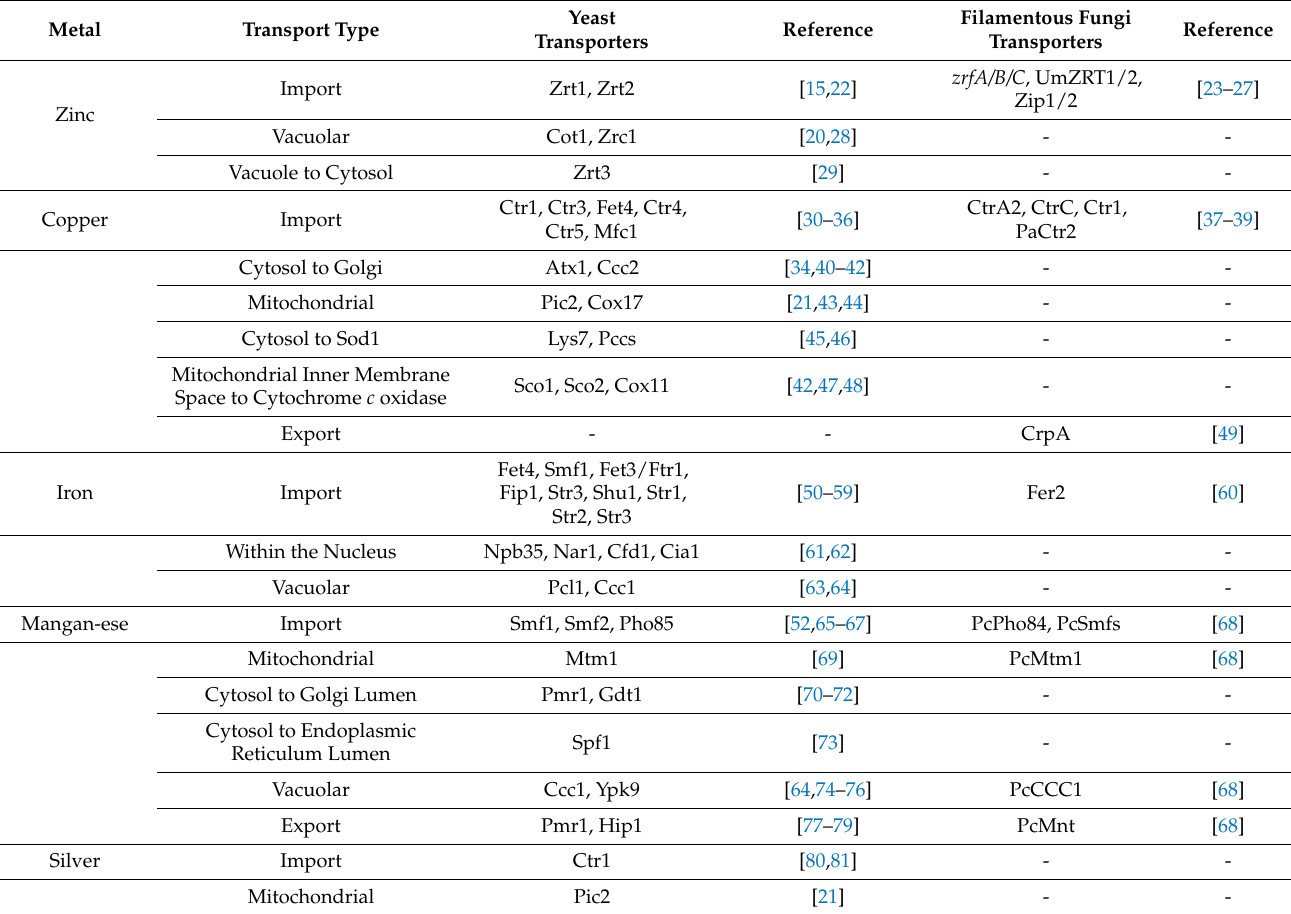
Figure 2. Yeast copper transport systems. In S. cerevisiae , cupric reductase, Fre1 reduces extracellular cupric oxide for transport across high and low-affinity copper membrane transports Ctr1 and Fet4. From the cytoplasm, Ccc2 shuttles Cu + to Golgi bodies, and Pic2 shuttles Cu + to the mitochondrial matrix. During meiosis in S. pombe , Mfc1 transports Cu + across the forespore membrane. Table 1. Fungal proteins involved in metal